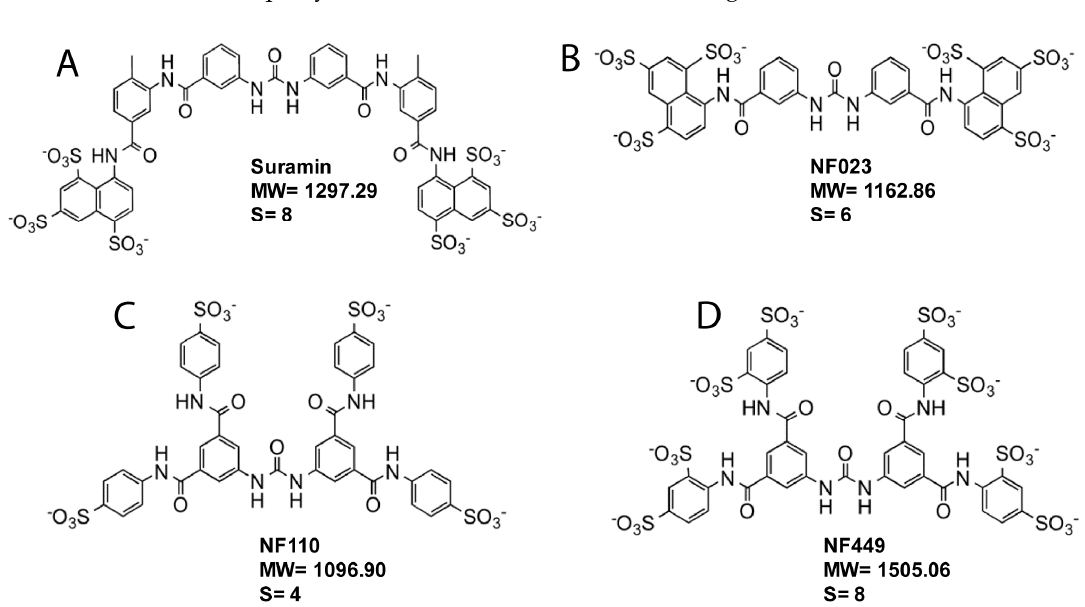
Figure 1. Structure of suramin and suramin analogs. ( A ) Suramin. ( B ) NF023. ( C ) NF110. ( D ) NF449. S = number of sulfate groups. MW = molecule weight.